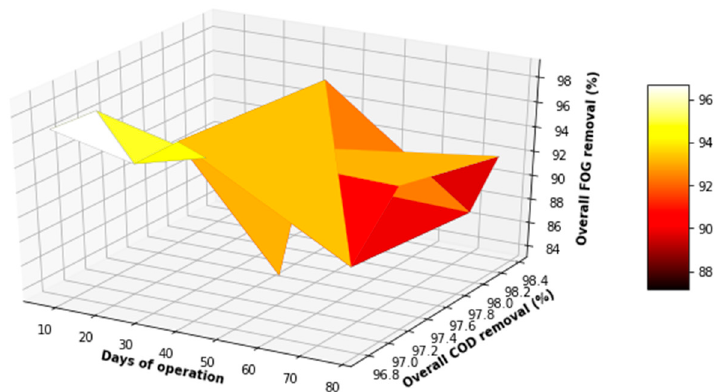
Figure 20. Boxplots of the parameters for the overall process.